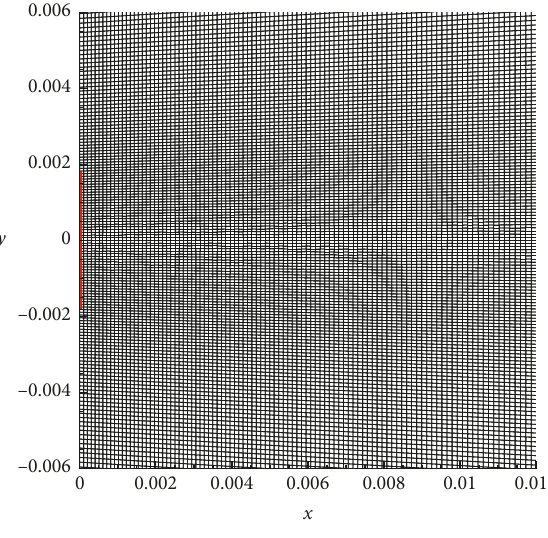
Figure 3: Mesh at the nozzle